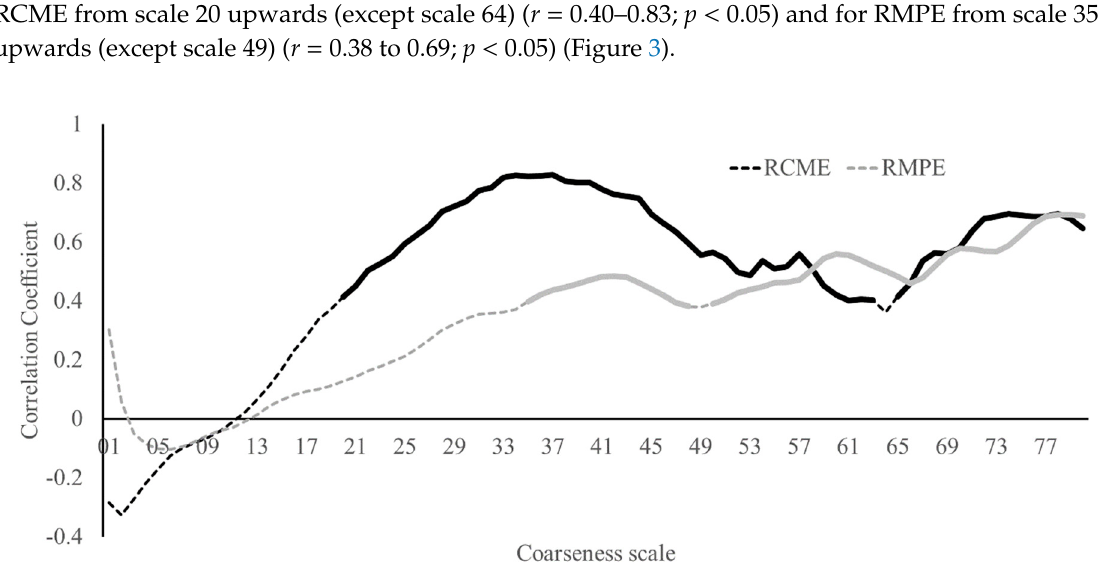
Figure 3. Pearson correlation coefficient calculated between the force plate-measured stride duration standard deviation and the waist-worn inertial measurement unit (IMU)-measured resultant acceleration-based multiscale sample entropy calculated with coarseness scales from 1 to 80. Solid line indicates a p < 0.05. The IMU sampling rate was 400 Hz, and the template length was 4 samples. RCME = refined composite multiscale entropy. RMPE = refined multiscale permutation entropy.